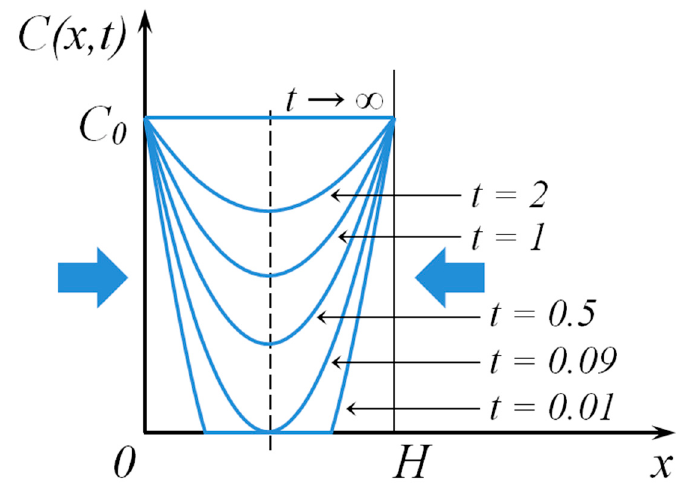
Figure 6. Distributions of sorbate concentration C at various times t in a plate of thickness H in the case of symmetrically directed sorbate flows.